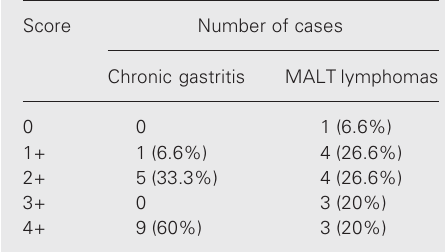
Table 1. Cases diagnosed as chronic gastritis and mucosa-associated lymphoid tissue (MALT) lym- phomas with the respective scores for reaction with